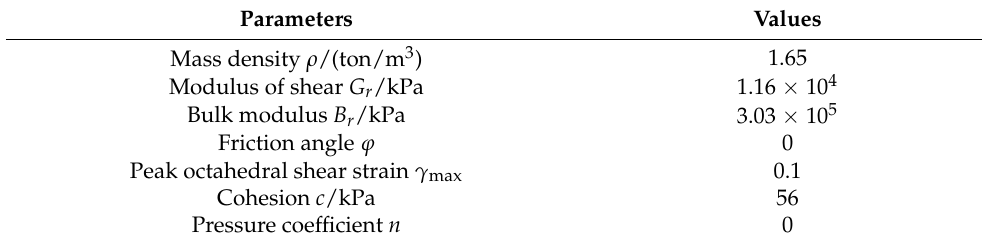
Table 6. The parameters of the PDMY model for clay